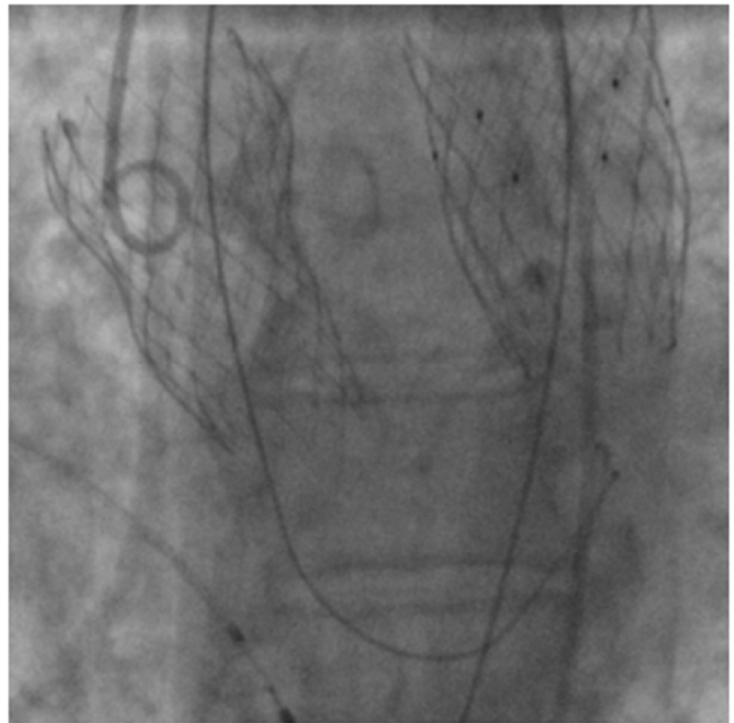
Figure 3. The second attempt of TAVI was performed using a 26 mm Medtronic Evolut R self- expanding transcatheter aortic valve with nitinol frame and a porcine pericardial tissue. The procedure was successful and the patient had no complications.